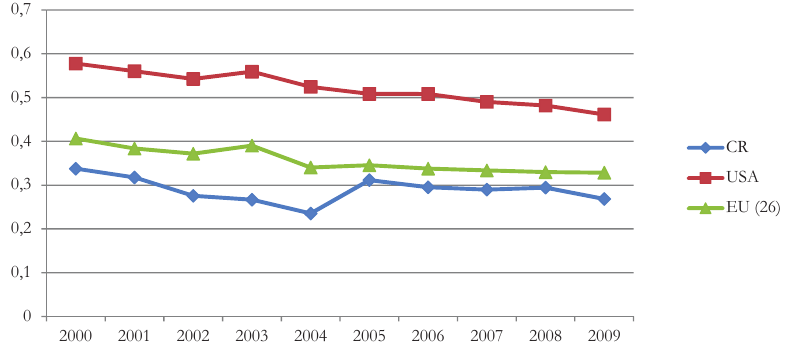
Fig. 2: Share of researchers to the tertiary education graduates in the period 2000-2009. Source: (Eurostat, 2013a), (Eurostat, 2013b), own processing.